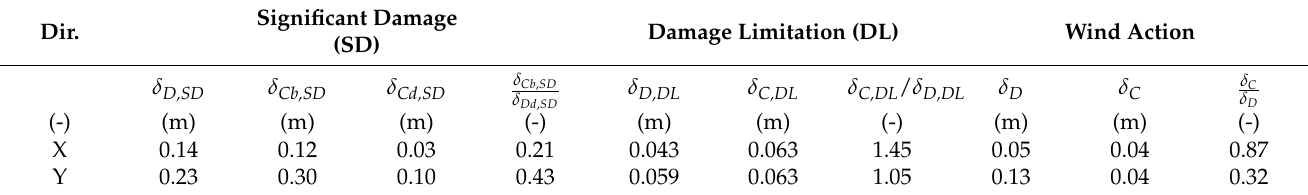
Table 1. Seismic and wind checks for the existing structure in terms of displacements.